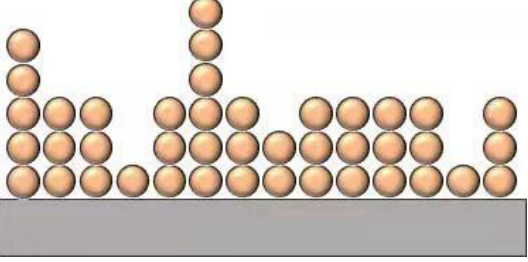
Fig. 8. BET multilayer adsorption model or random distribution of surfactant oil molecules (adsorbate) on the friction surface (adsorbent) in the form of circles included in one, two, three, and so on